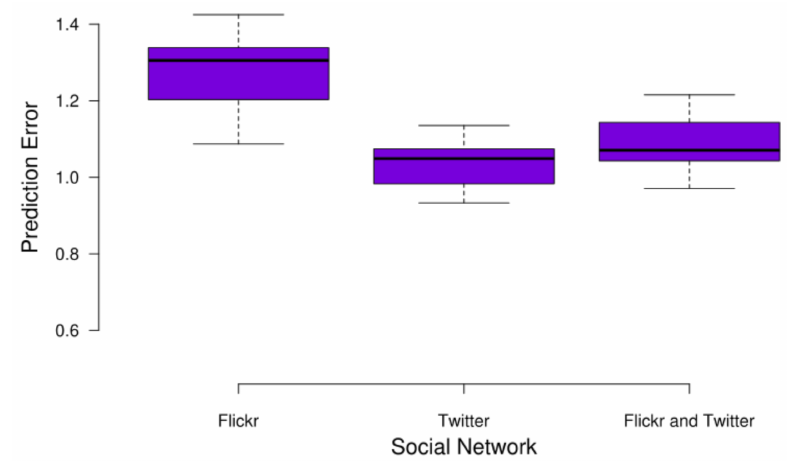
Figure 13. Average prediction error with respect to the target